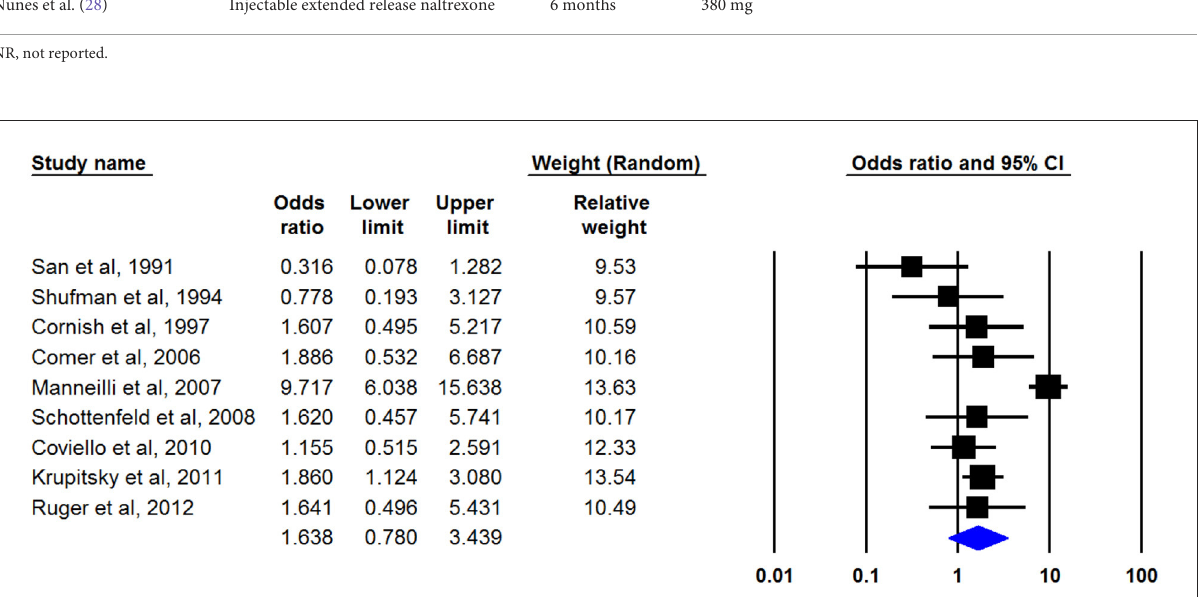
FIGURE2 Pooled OR of retention in treatment